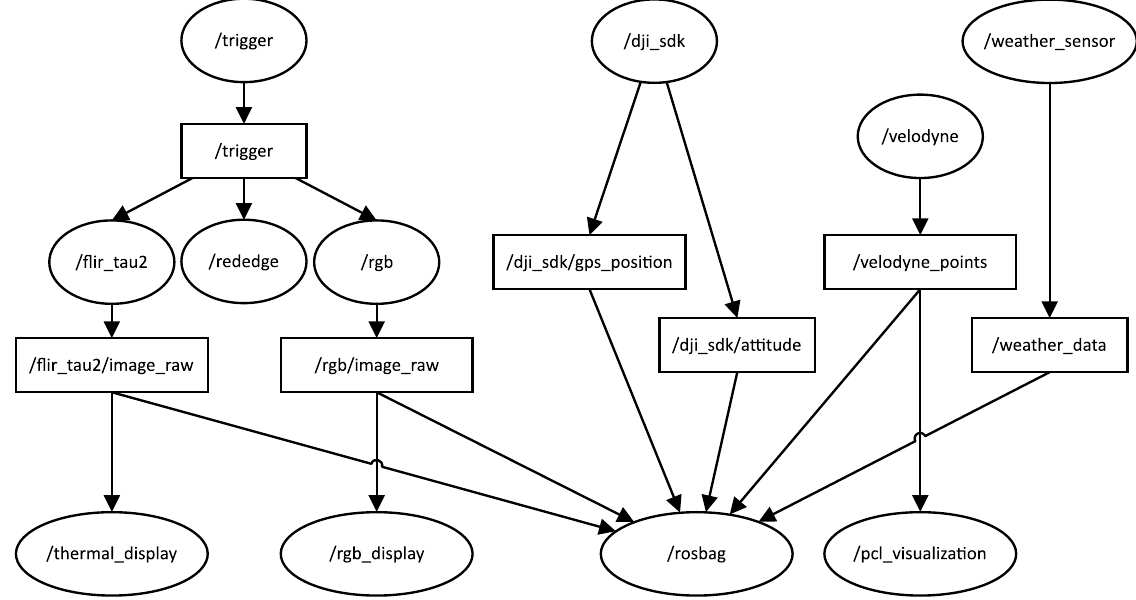
Figure 5. ROS computation graph. Ovals indicate nodes and rectangles indicate topics. Three data visualization nodes, thermal_display , rgb_display , and pcl_visualization , were implemented to visualize the RGB image, thermal image, and the LiDAR data.